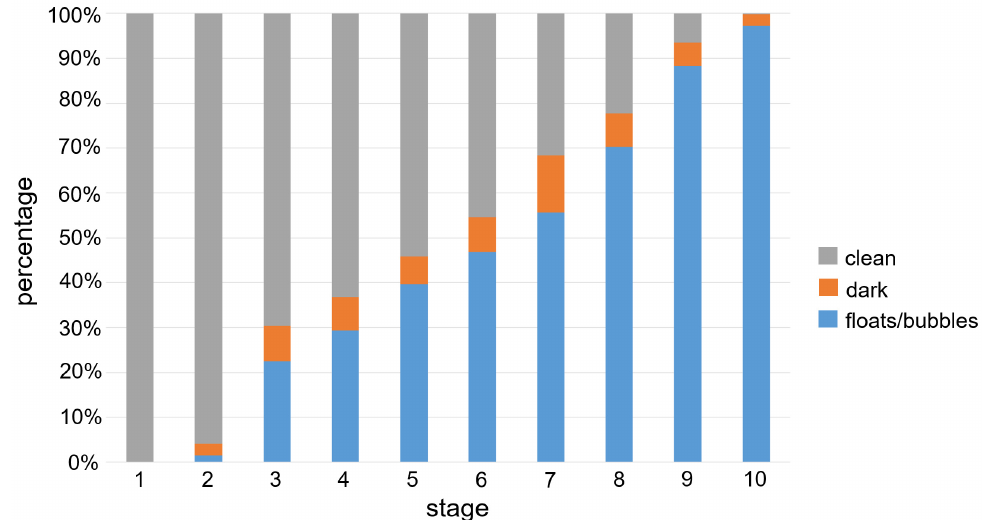
Figure 3. Class balance for each stage in our dataset. We calculate the percentage (vertical line) by averaging the ratio of the size of each class to image size.